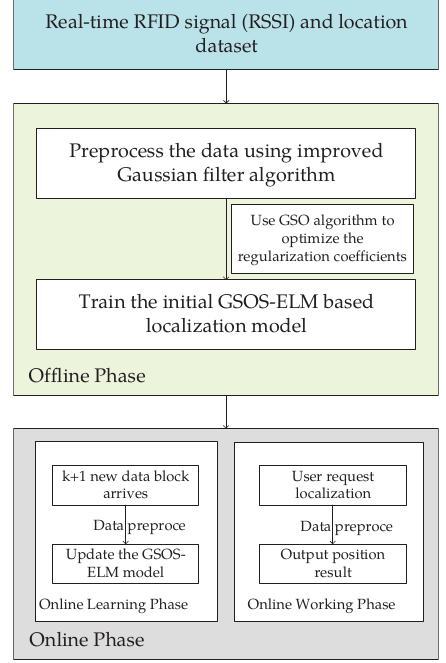
Figure 1. The Framework of RFID Localization System Using GSOS-ELM.